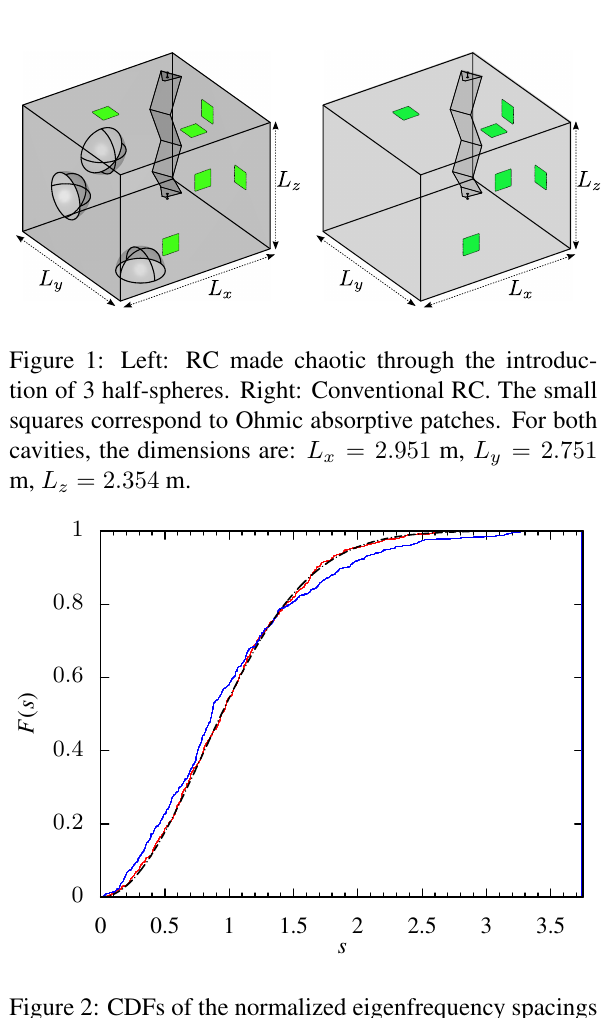
Figure 2: CDFs of the normalized eigenfrequency spacings for the conventional RC (blue curve) and for the chaotic RC (red curve) are compared to the Wigner Surmise (dash-